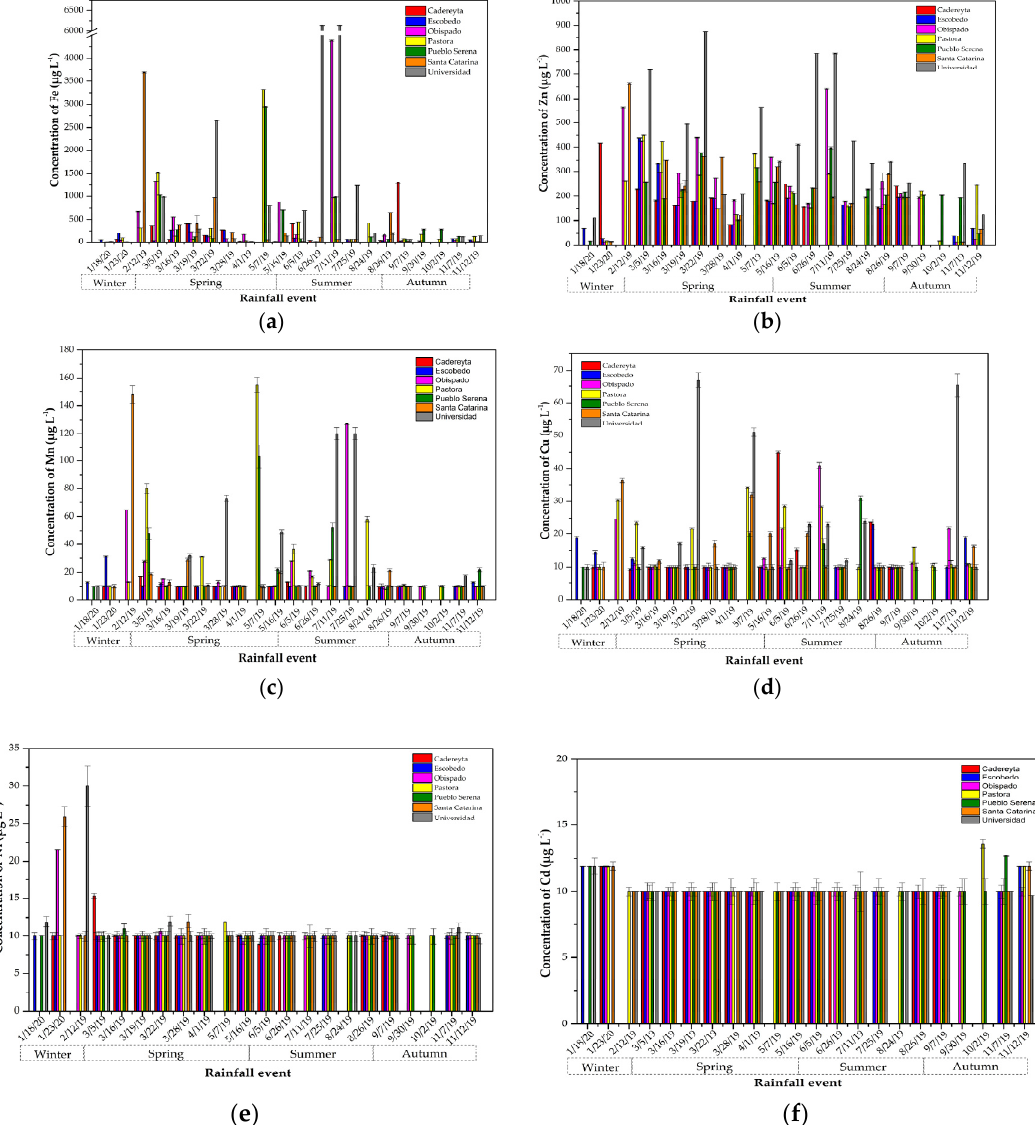
Figure 6. Spatial and temporal distribution concentrations of metals in bulk precipitation in MAM, ( a ) Fe, ( b ) Zn, ( c ) Mn, ( d ) Cu, ( e ) Ni and, ( f ) Cd. Plotted data are means ± standard error.